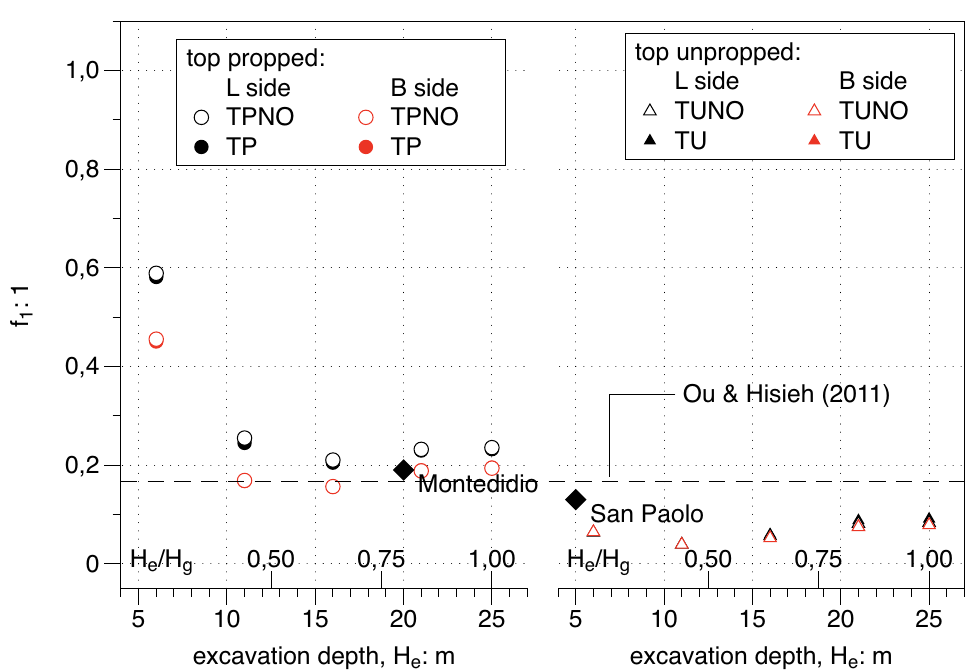
Figure 16. Dependency on the excavation depth H e of the value f 1 of the transversal settlement function f at a distance y m PIZ = 1